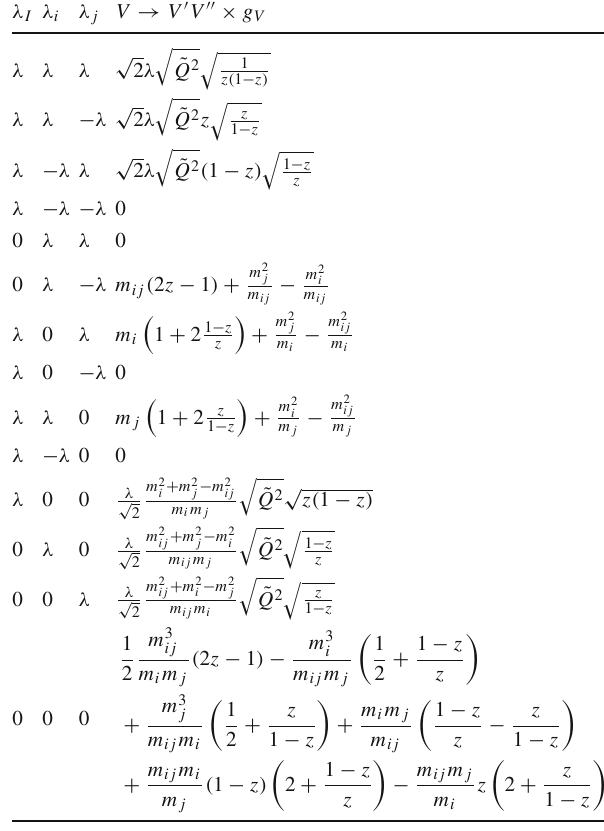
Table 3 Branching amplitudes for vector boson emission off a vector boson